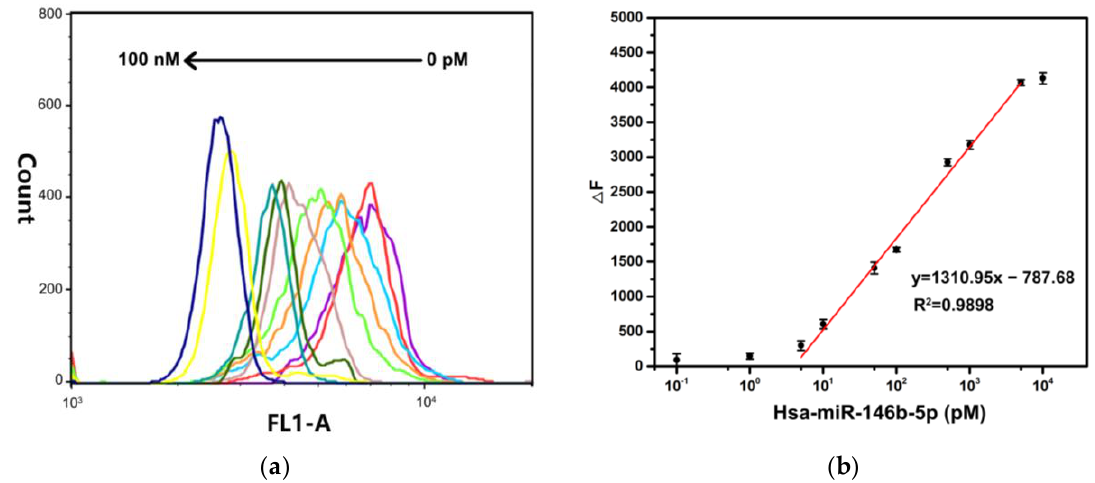
Figure 4. ( a ) Fluorescence spectra and ( b ) corresponding to the data analysis of the TSDR-based flow cytometric assay towards the concentrations of hsa-miR-146b-5p ranging from 0 pM to 100 nM. Error bars mean standard deviations ( n = 3).